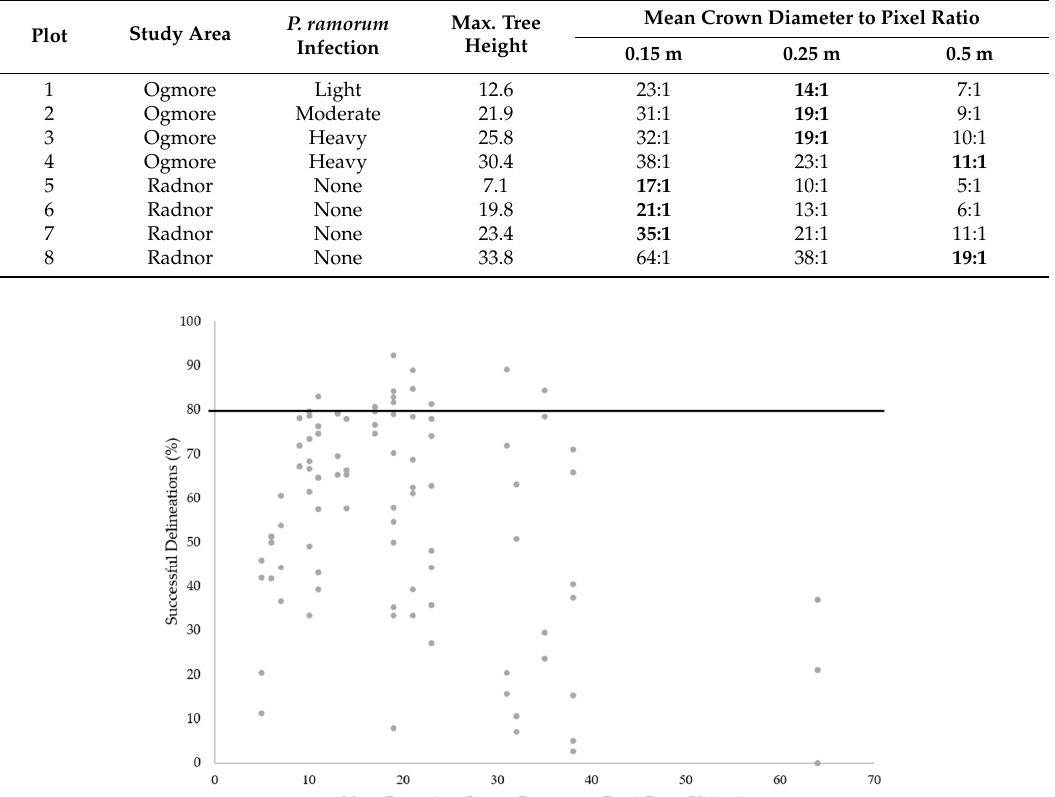
Table 12. The mean equivalent crown diameter to pixel ratio for each plot across the three different CHM pixel sizes. The values highlighted in bold demonstrate those associated with the highest successful delineation percentage for the sample plot.